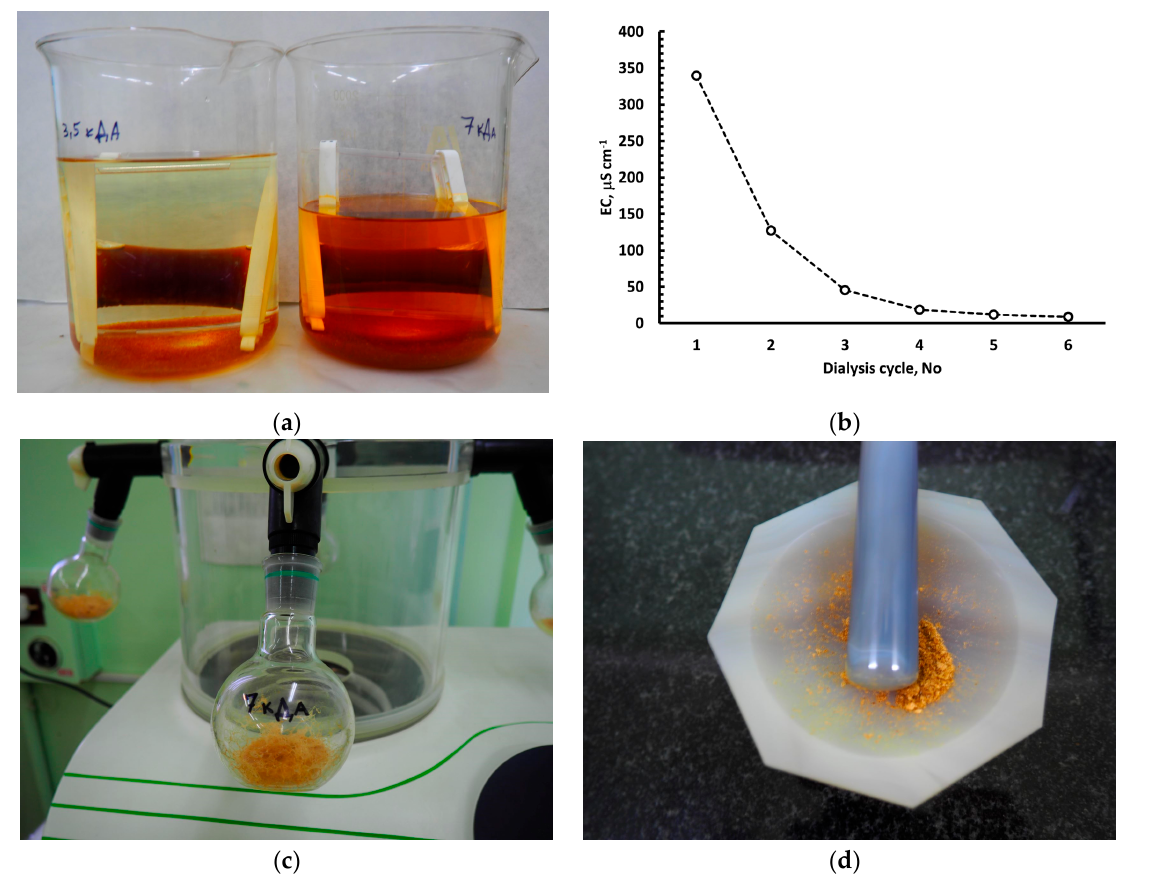
Figure 3. Successive steps of the preparation of a sample of dry HMWDOM-H from a soil solution: ( a ) Dialysis of the soil solution concentrate with MEMBRA-CEL dialysis bags with different pore sizes, ( b ) Control of the specific electrical conductivity ( EC ) of the sequential washings with easily soluble salts from the soil solution concentrate by dialysis; ( c ) Lyophilization of the HMWDOM dialysate of soil solution for subsequent analysis of its makeup by 13 C MAS NMR; ( d ) Finished sample of lyophilized HMWDOM-H.